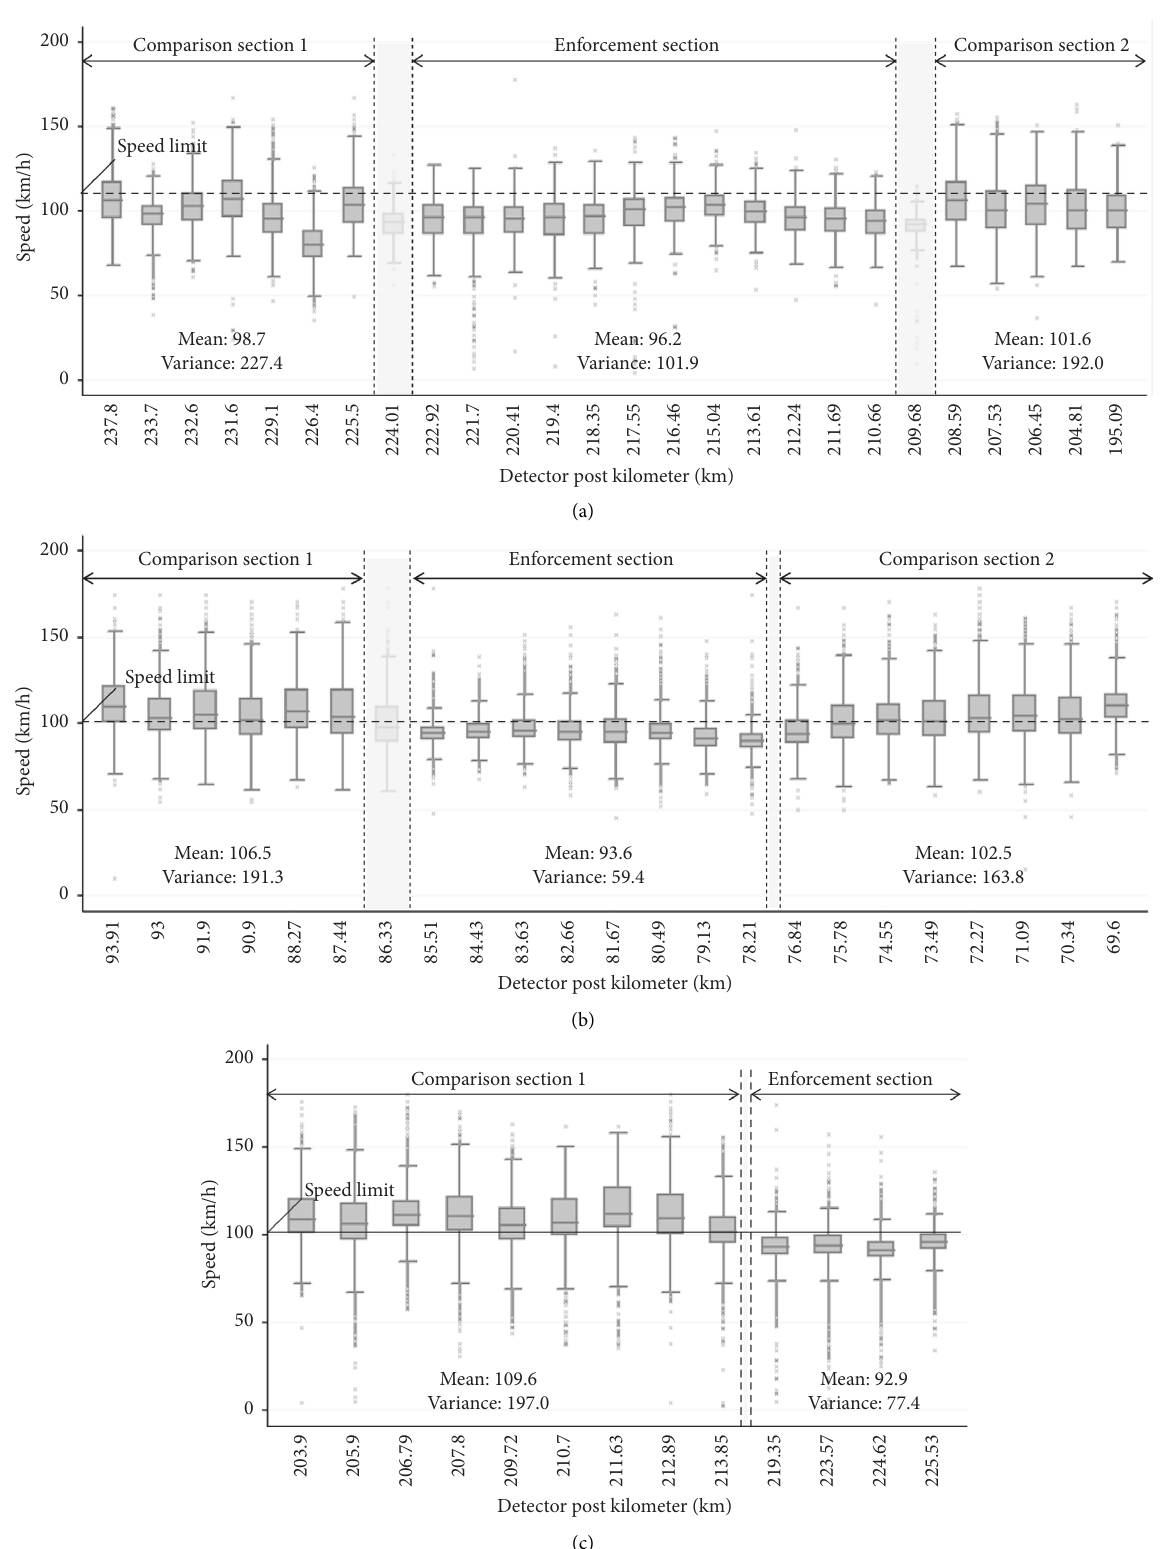
Figure 4: Speed distributions at loop detectors of three different study sites: (a) Jungbunaeruk Expressway (ID 6), (b) Daejeon–Tongyeong Expressway (ID 8), and (c) Yongdong Expressway (ID